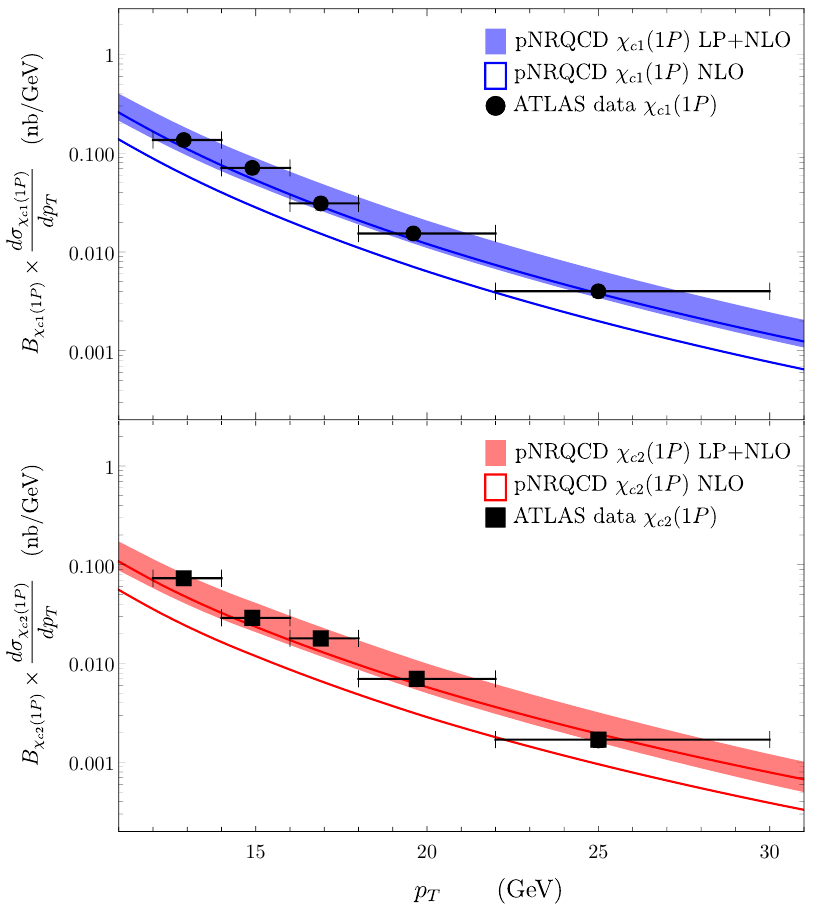
Figure 4 . Production cross sections of the χ c 1 (1 P ) and χ c 2 (1 P ) at the LHC center of mass energy √ s = 7 TeV and in the rapidity range | y | < 0 . 75 compared with ATLAS measurements [41]. LDMEs do not depend on the direction of the gauge-completion Wilson lines, and, there- fore, do not depend on the polarization λ (see for instance refs. [42, 49–53]). This amounts at assuming that the polarized color-octet LDMEs h Ω | χ † σ i T a ψ Φ † ab ψ † σ i T c χ | Ω i can be related for any polarization λ of the χ